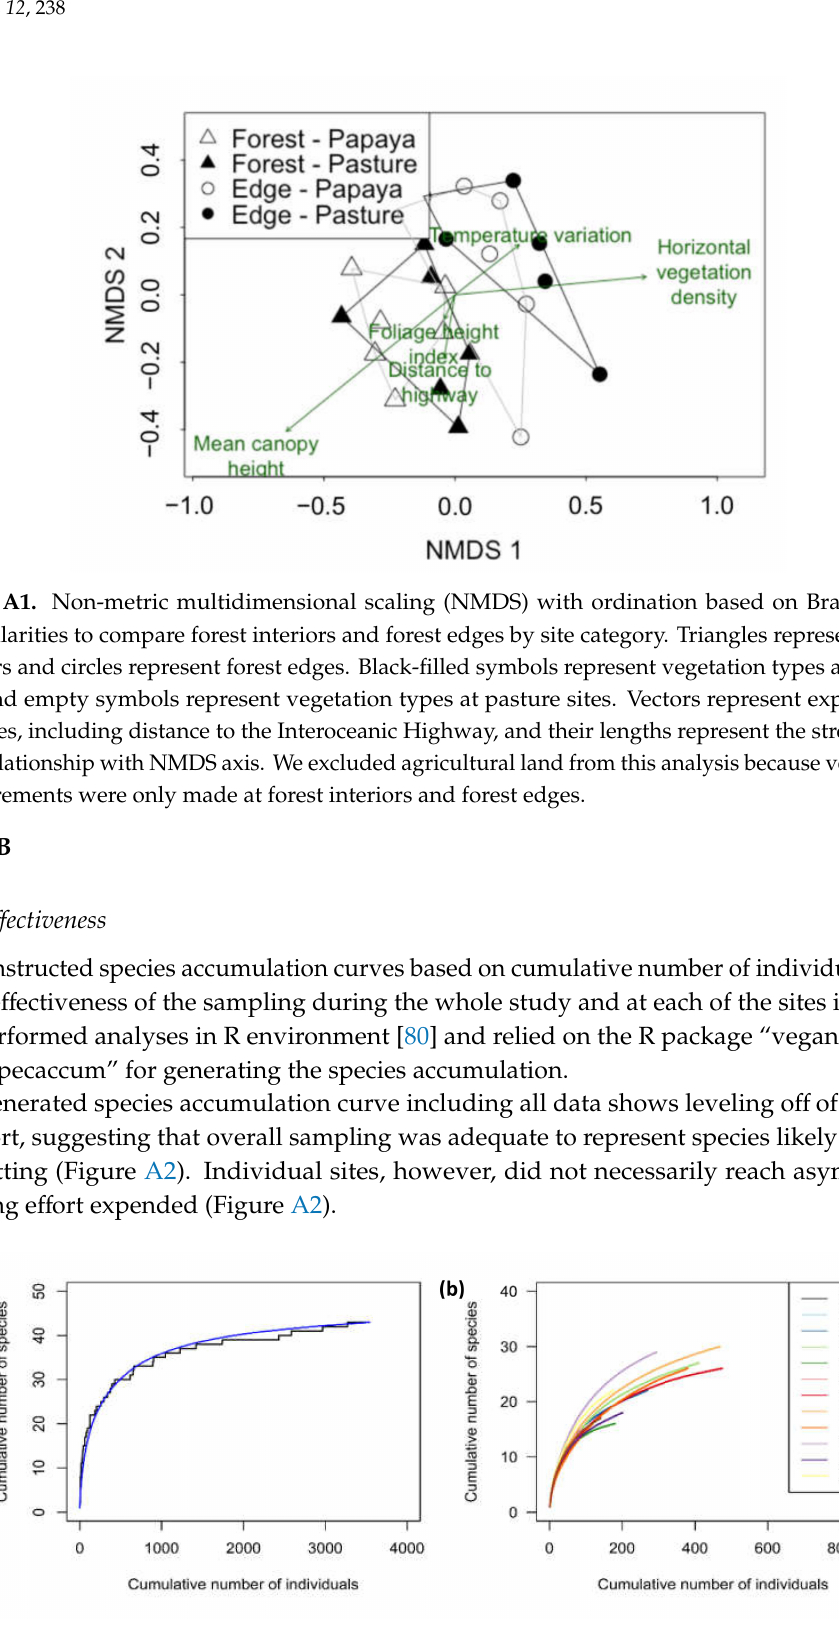
Figure A2. Species accumulation curves; ( a ) cumulative number of species across all sites versus sample e ff ort (number of individuals captured). Jagged curves represent data as it was collected. Smoothed line represents random collections of the data; ( b ) cumulative number of species per study site based on number of individuals